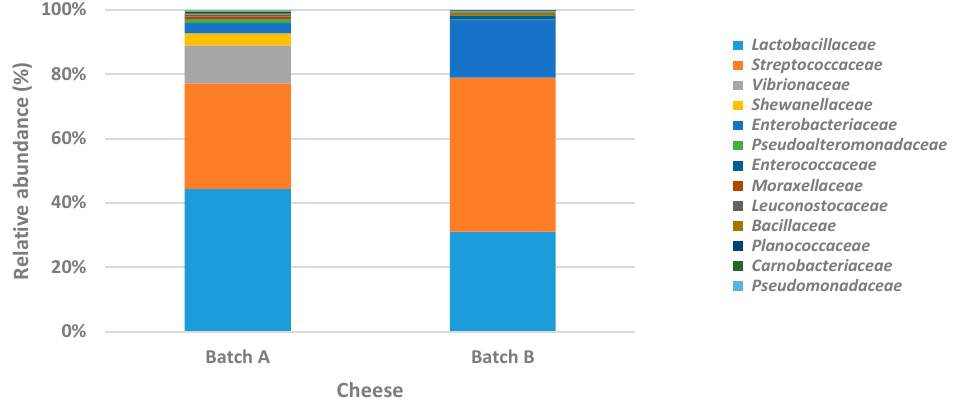
Figure 2. Abundances of bacterial families (relative abundances, %) detected on the two batches of Galotyri-like acid-curd cheese by next-generation sequencing.